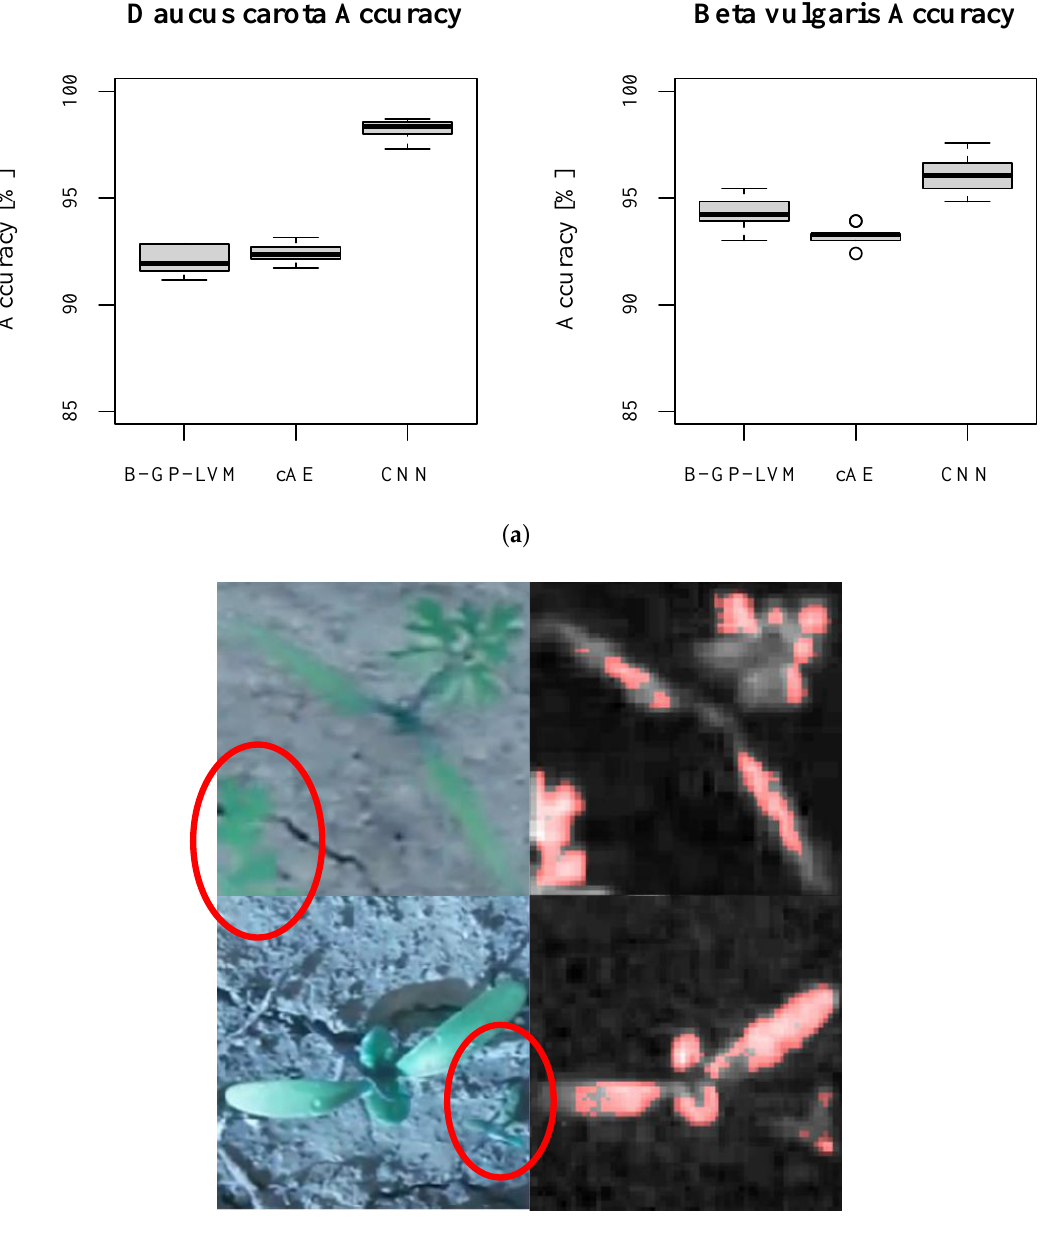
Figure 5. Prediction accuracy of the unsupervised models ( a ) Prediction accuracy of the proposed models in comparison to the CNN for Daucus carota ( left ) and Beta vulgaris ( right ). In both cases, the CNN outperforms the unsupervised models. In ( b ) Input image for CNN classification ( left ) and pixels used for decision ( right ), correctly classified images are shown. The CNN relies on the red colored pixels. These areas includes non-plant